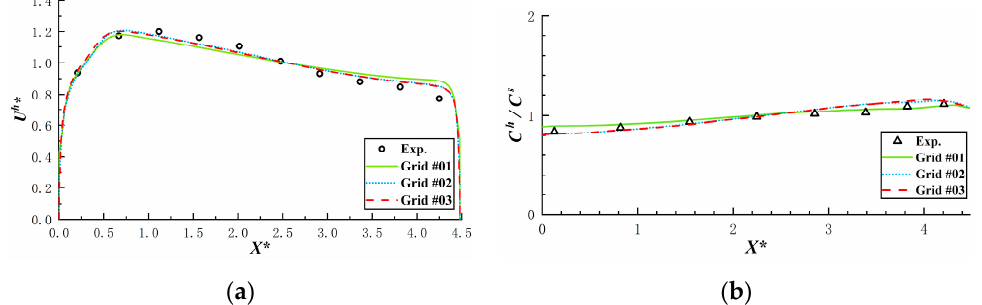
Figure 4. The grid independence test results: ( a ) normalized depth-averaged streamwise velocity